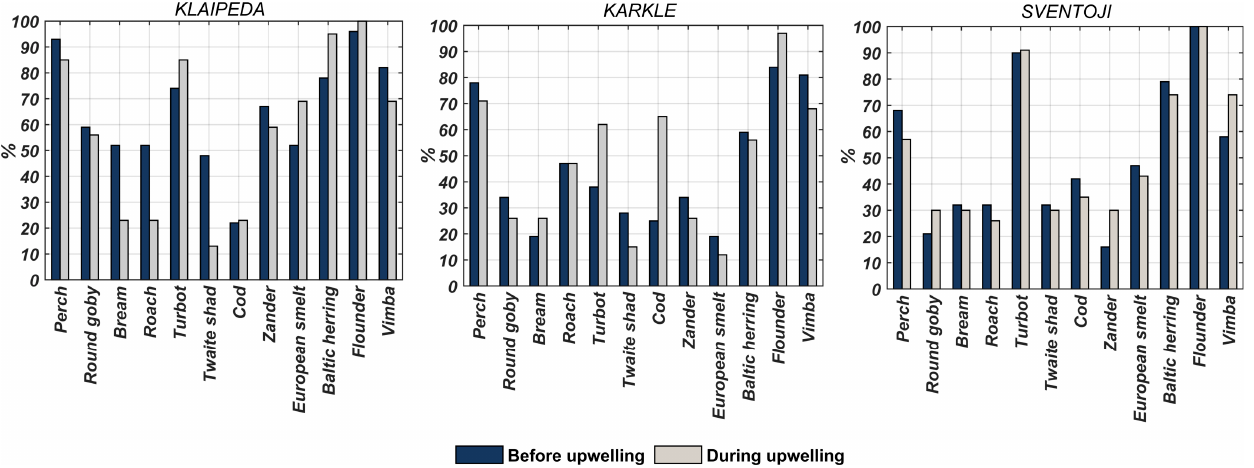
Figure 2. The frequency of occurrence (%) of different fish species before and during upwelling